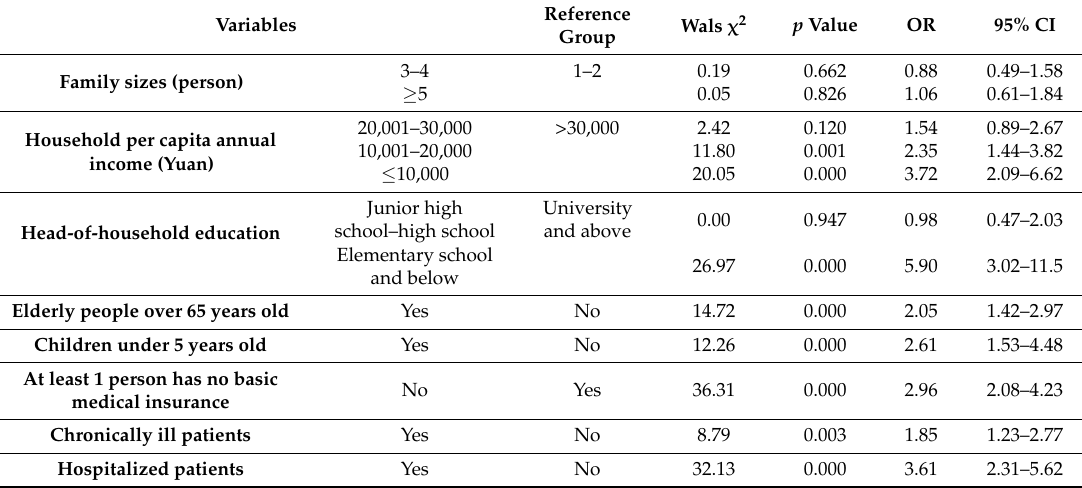
Table 2. Multivariate logistic regression analysis of CHE of migrant workers’ families.